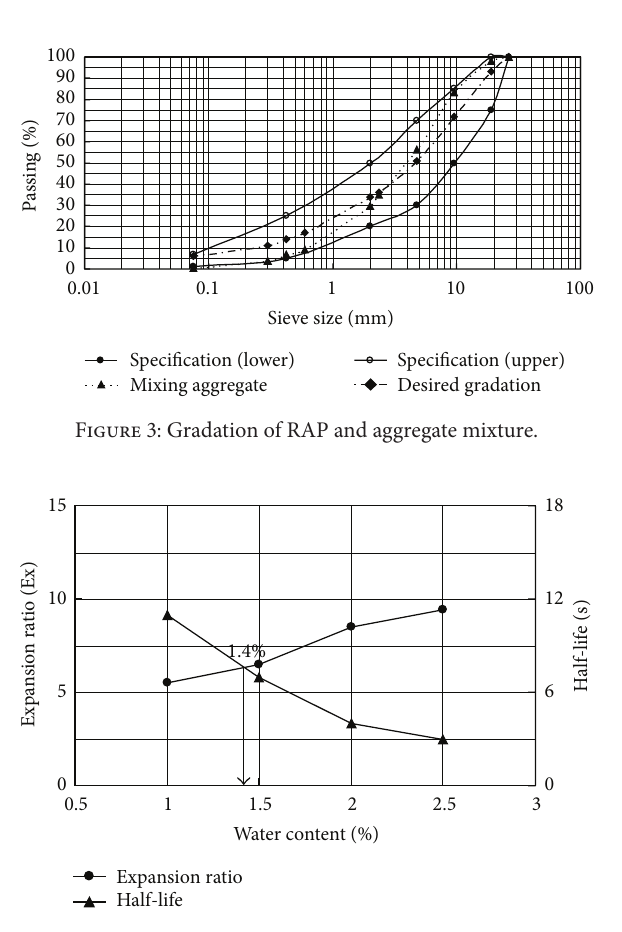
Figure 4: Expansion ratio and half-Life of foamed asphalt.